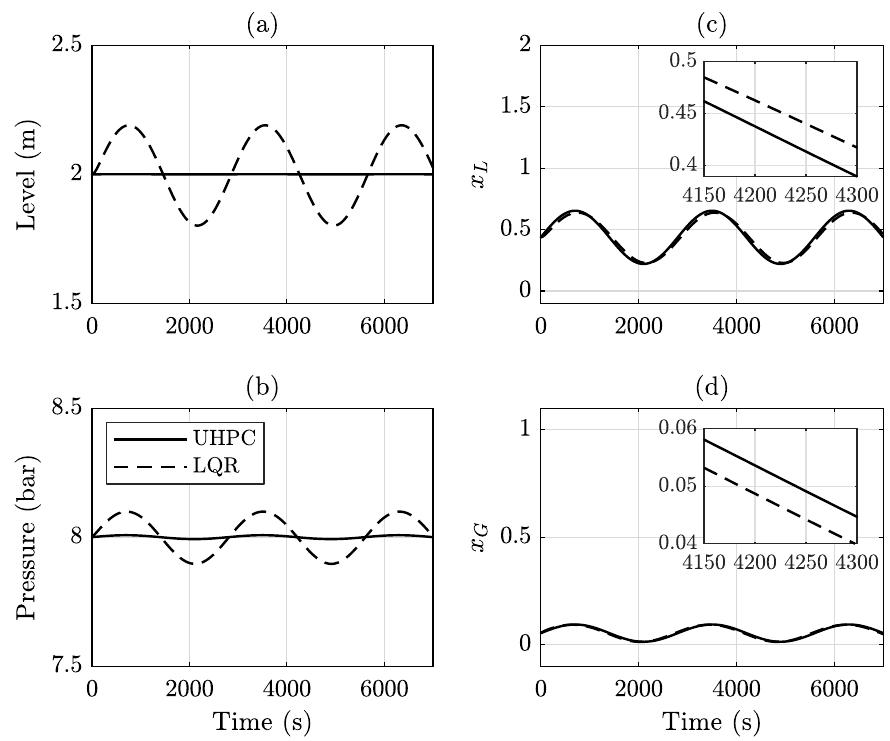
Figure 6. Simulation of the closed-loop system with slug disturbance. ( a , b ) the level and pressure, respectively; ( c , d ) the control signals x L and x G , where a zoom is included to highlight the difference between the LQR and UHPC